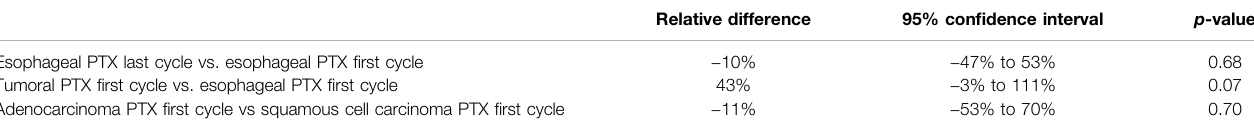
TABLE 2 | Comparisons of tissue pharmacokinetics.